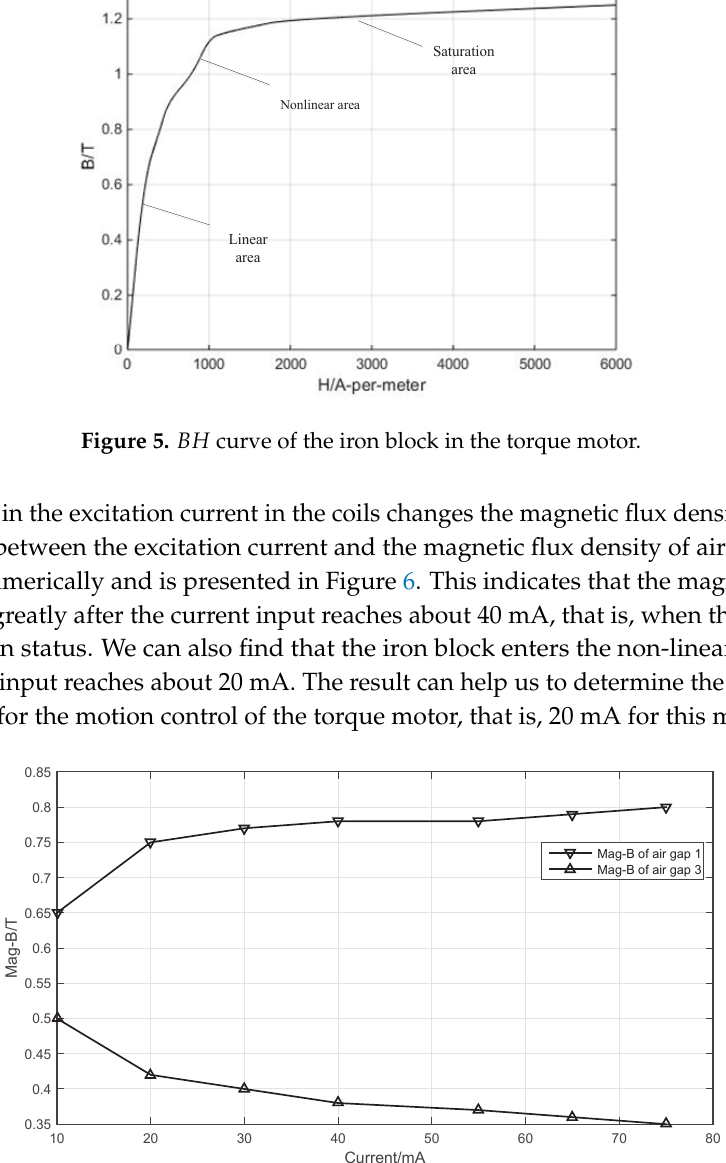
Figure 6. Magnetic flux density of air gaps 1 and 3 with different values of current